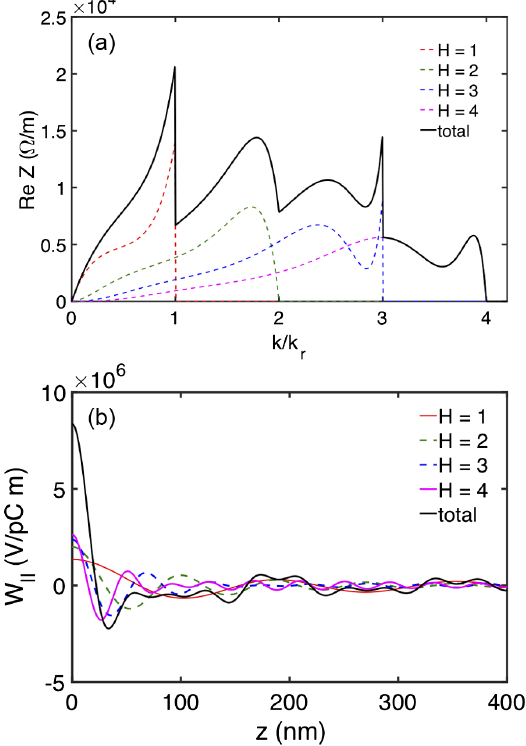
FIG. 1. The undulator radiation impedances (a) and the corre- sponding coherent radiation wake functions (b) for the first four individual harmonics and for the total superposition of them (black curve). Here z > 0 indicates the bunch head or in the forward direction. The relevant parameters are K ¼ 4 . 2 ,